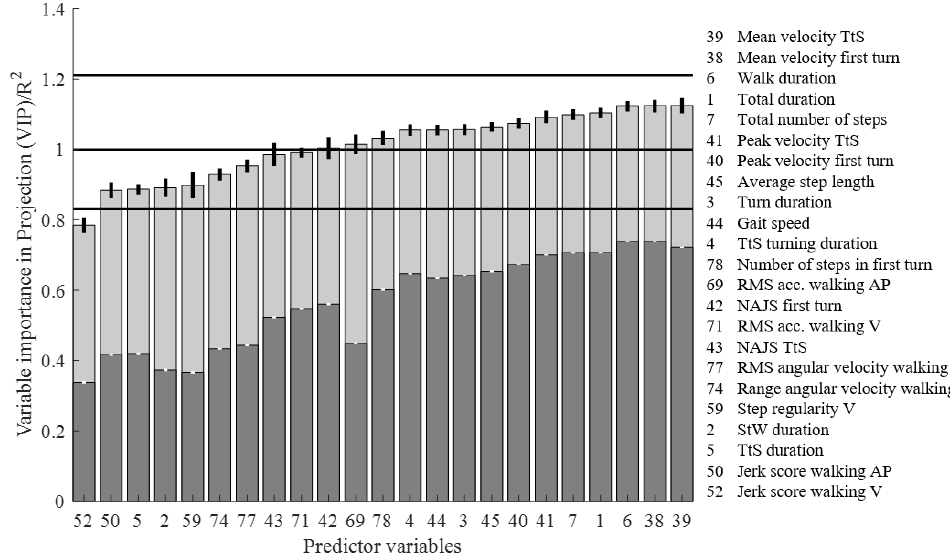
Figure 5. The VIP scores (light grey) and R 2 (dark grey) of the iTUG features selected in the PLSR model. The horizontal lines represent the lower (0.83), middle (1) and upper (1.21) cut-off values used for interpreting the VIP of individual predictor variables.